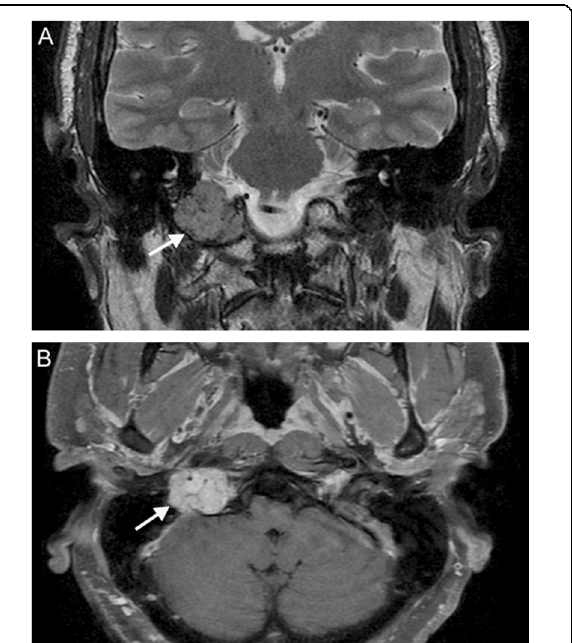
Fig. 13 Jugular paraganglioma. A 55-year-old woman with relatively sudden onset hoarseness and dysphagia to liquids, who was found to have right vocal cord paralysis on laryngoscopy. Coronal T2 ( a ) and axial T1 post-contrast ( b ) MR images reveal a T2-isointense, avidly-enhancing lesion at the right jugular fossa (arrows) extending intracranially, with mild mass effect upon the right cerebellar hemisphere. Foci of low signal ( “ pepper ” ) represent flow voids, reflecting hypervascularity. Based on location and appearance, findings are consistent with a jugular paraganglioma (glomus jugulare